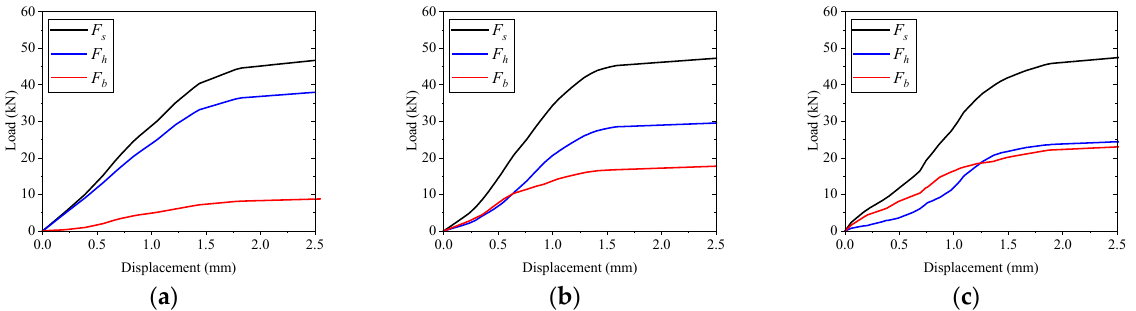
Figure 17. Distribution of headed bar force among specimens with different lap length ( a ) Specimen M4-D12-6d; ( b ) Specimen M4-D12-7.5d; ( c ) Specimen M4-D12-9d.